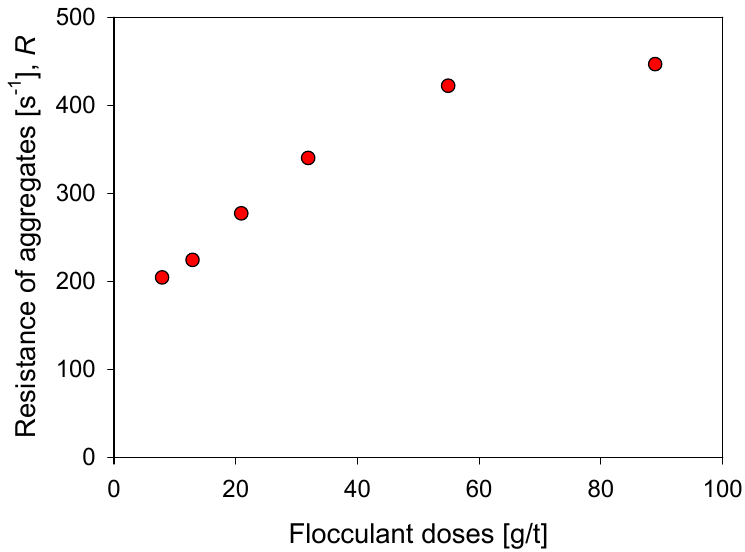
Figure 9. Effect of the flocculant dose on the resistance of kaolin aggregates ( R ) flocculated in SW after 60 s flocculation time.